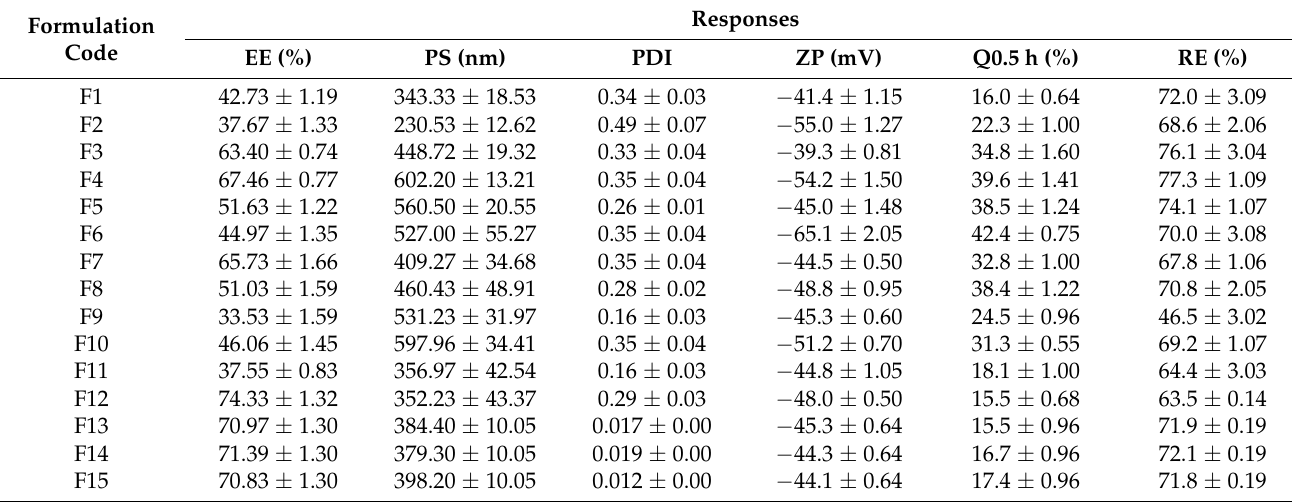
Table 4. Measured responses of Box–Behnken (3 3 ) design for the prepared zolmitriptan-loaded bilosomes.